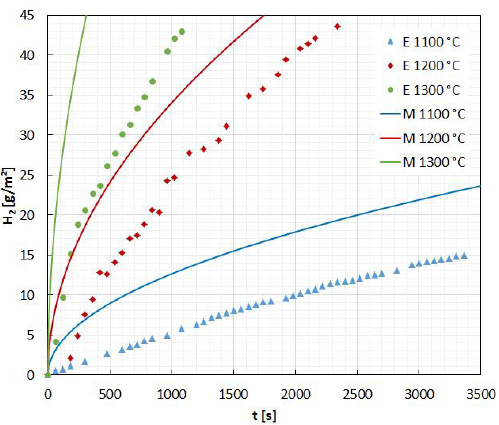
Figure 13. Evolution of the hydrogen generation curves for AISI 348 at 1100 °C, 1200 °C, 1300 °C in water, comparing typical experimental results (E) with the upper confidence interval model (M), considering that confidence level is